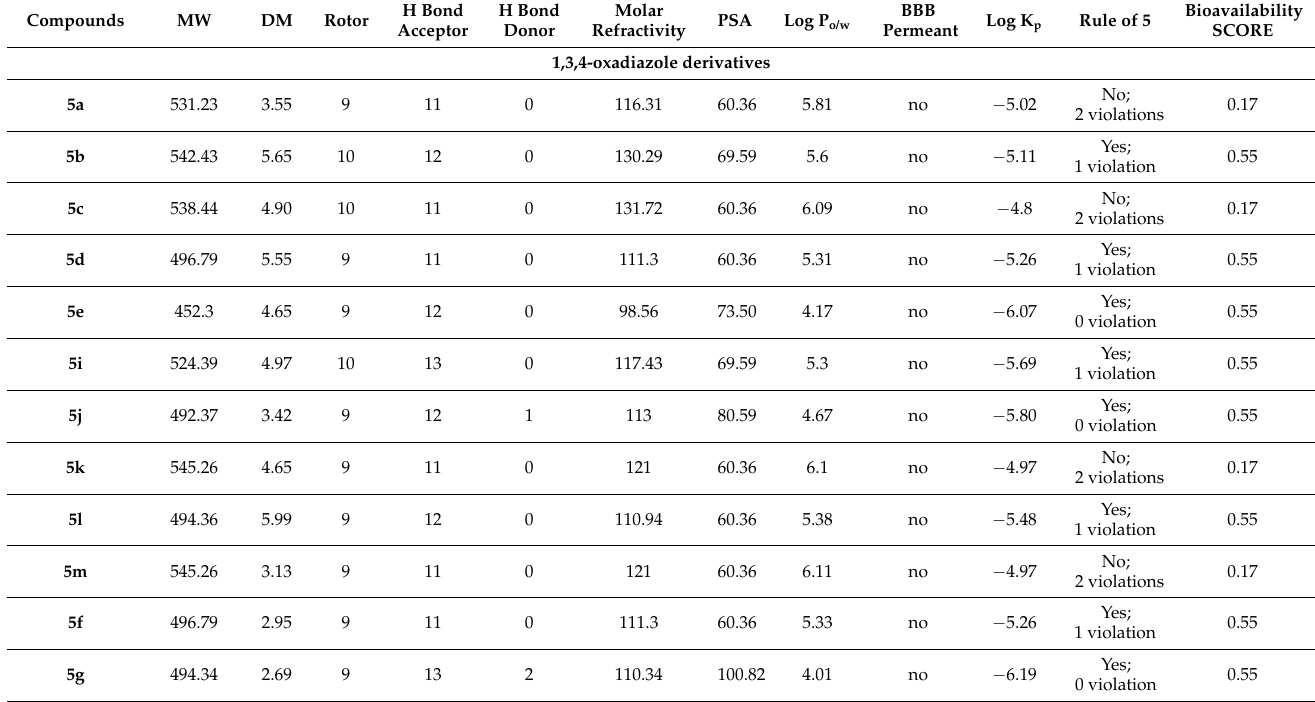
Table 6. Predicted ADMET properties for synthesized 1,3,4-oxadiazole